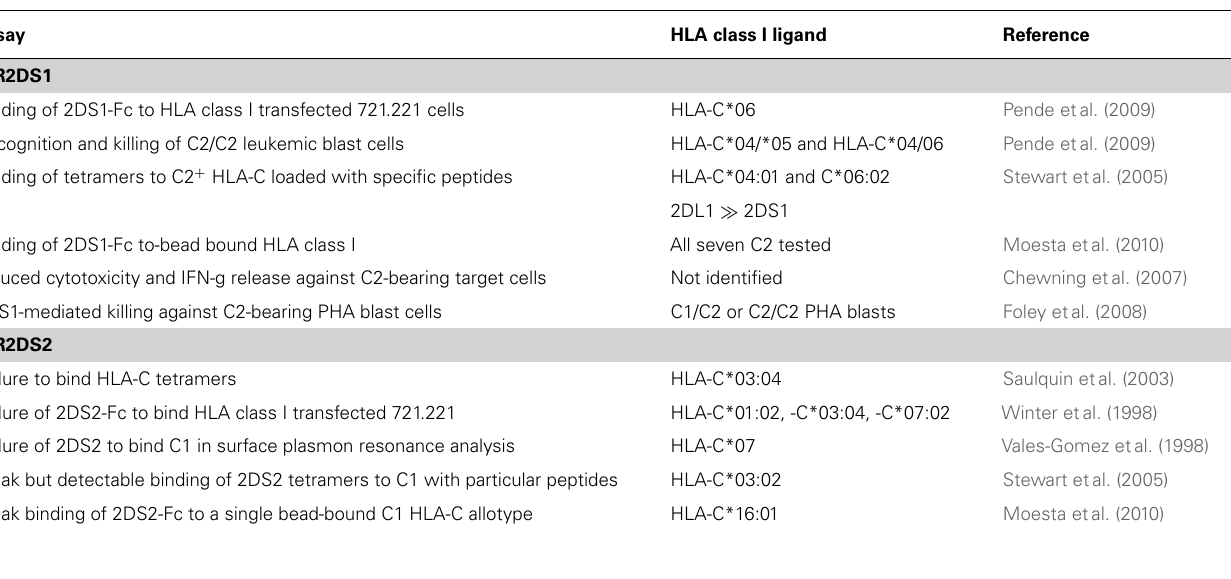
Table 1 | Direct HLA interactions of KIR2DS1 and